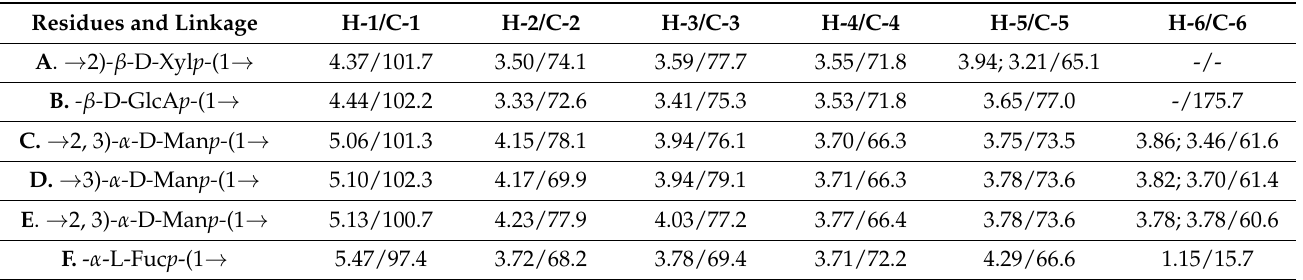
Table 1. 1 H and 13 C chemical shifts of